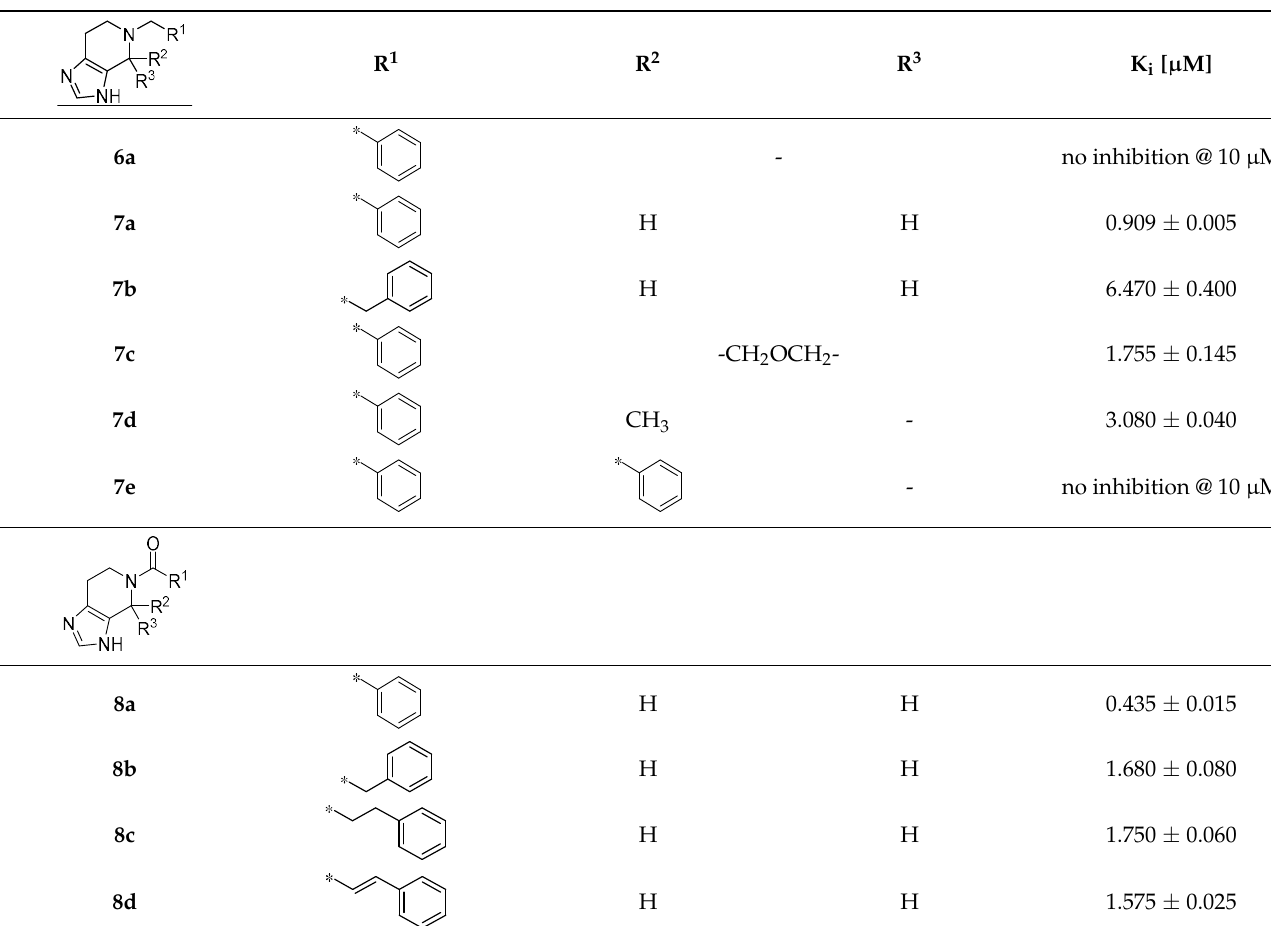
Table 1. Inhibition of PgQC by tetrahydroimidazo[4,5- c ]pyridines with alkyl and acyl modifications.